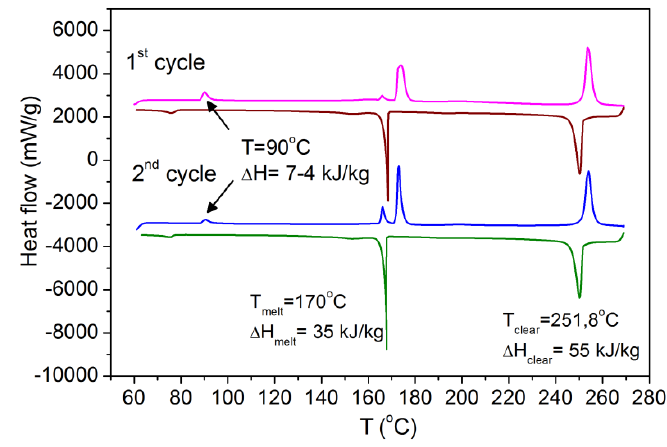
Figure 7. Differential scanning calorimetry (DSC) scans of first and second heating/cooling cycle for 10-BPhCOOH.